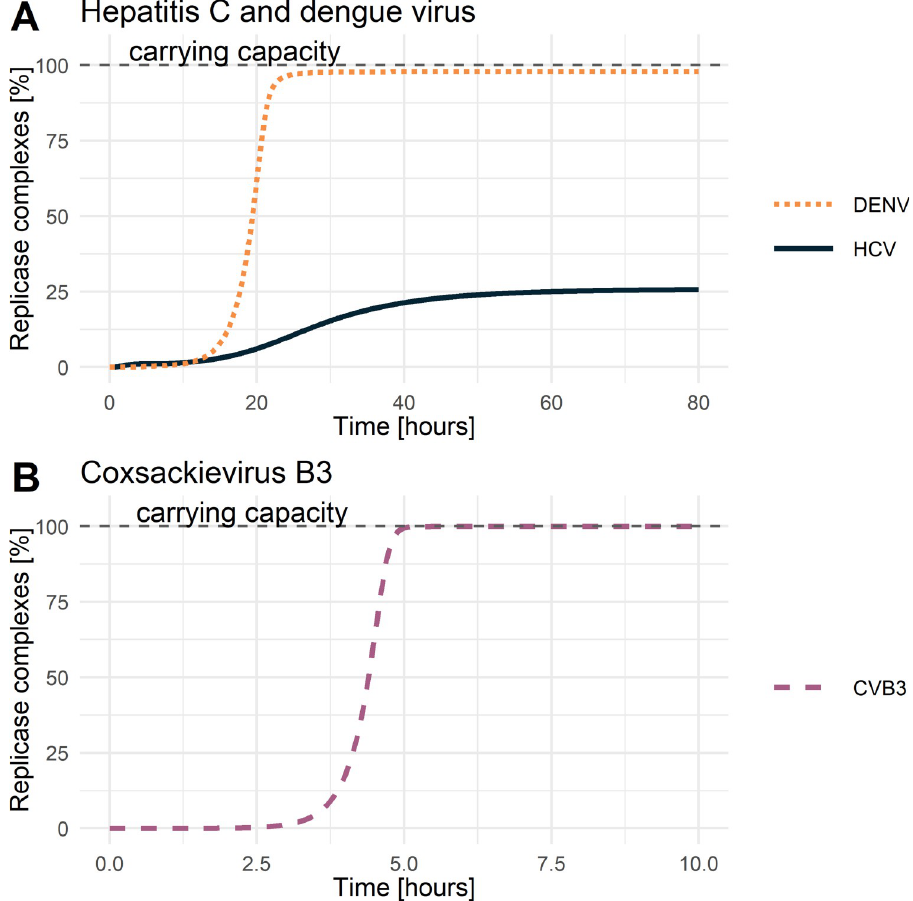
Fig 5. Replicase complexes over time. Dynamics of replicase complexes for A) hepatitis C and dengue virus, B) coxsackievirus B3. The dashed grey line represents the carrying capacity or the maximum number of formed replicase